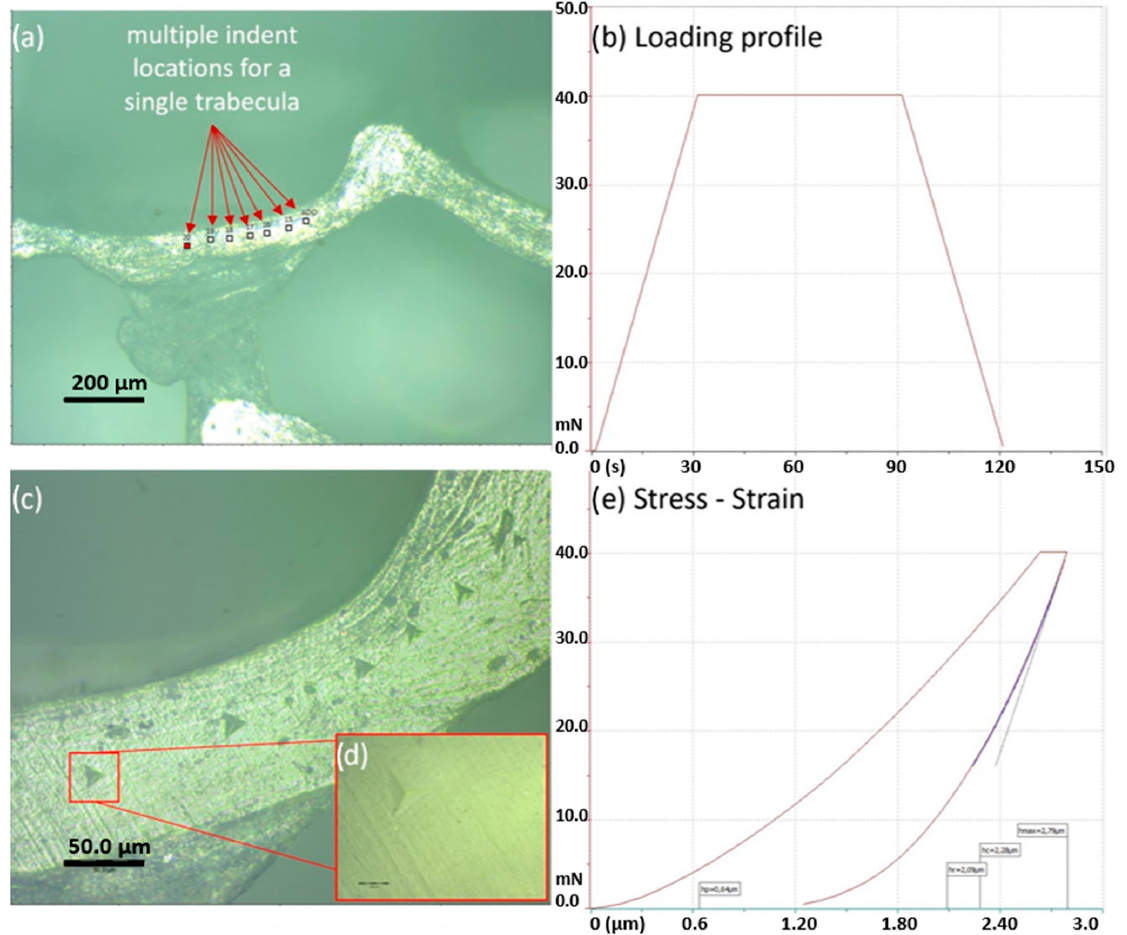
Figure 4. Trabeculae micro indentation. ( a ) Manually placed indent locations for each selected trabecula, ( b ) indentation trapezoidal loading profile, ( c ) stress–strain plot showing a single load–unload cycle, ( d ) indented area and ( e ) view of a single indent at original magnification ×100.